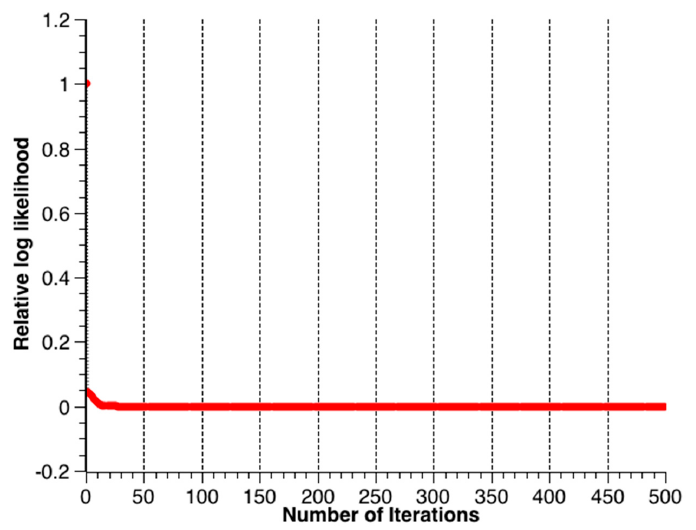
Figure 7. Relative log-likelihood of two consecutive iterations.